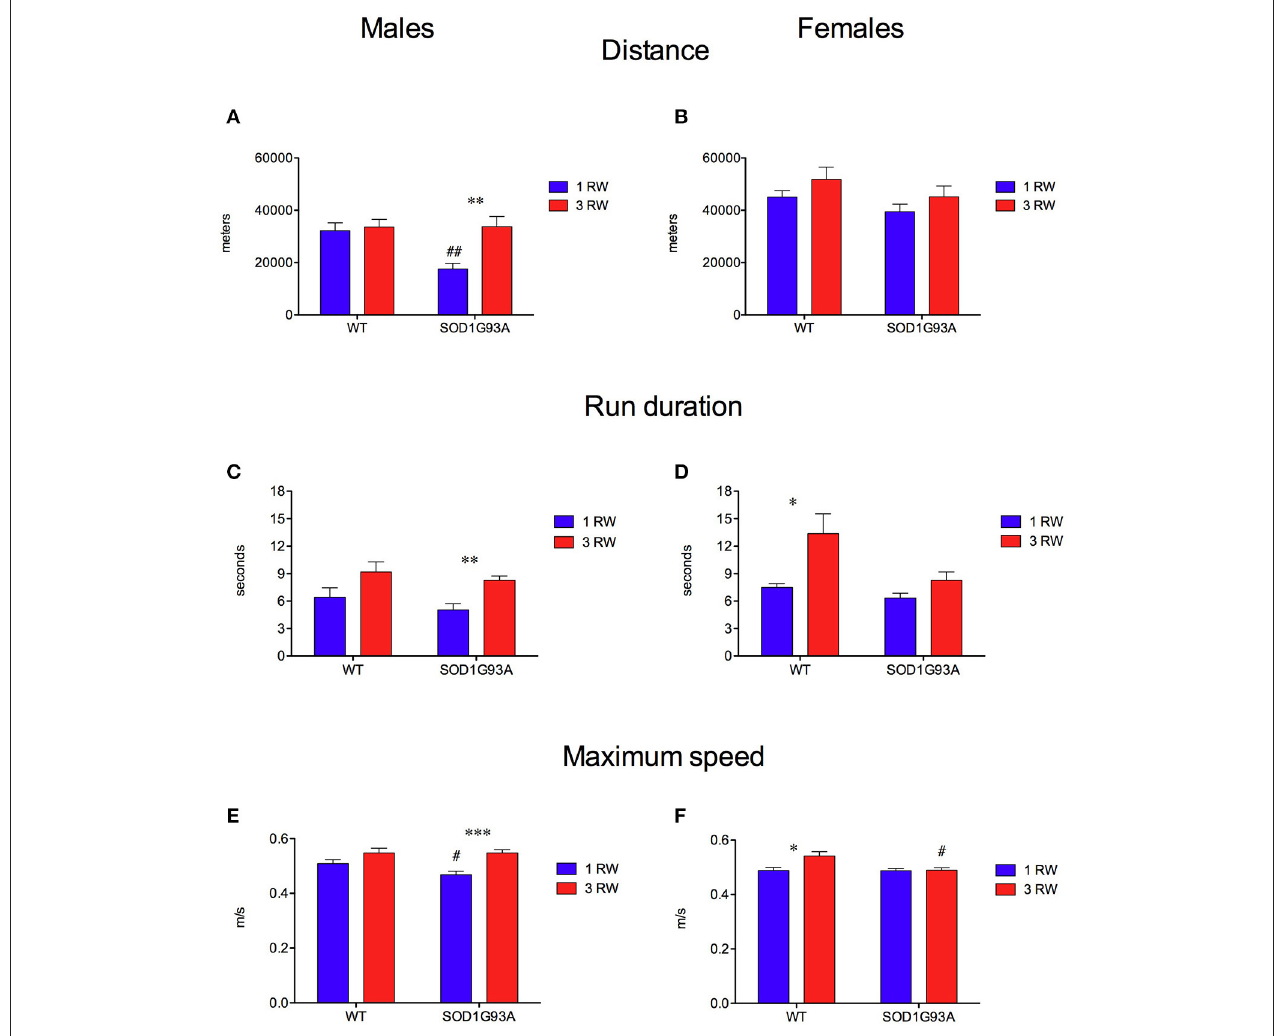
FIGURE 5 | Effect of exercise experience on running parameters during week 2 at age 24–26 weeks. (A,B) Total distance traveled (meters) on running wheels in male and female mice (mean ± s.e.m. of session’s second week). (A) Males, ANOVA: Genotype factor, F (1,33) = 5.674, P = 0.023; Exercise factor, F (1,33) = 8.502, P = 0.0063; Genotype × Exercise, F (1,33) = 5.906, P = 0.02. t -test: ** P = 0.0014 1 RW vs. 3 RW in SOD1G93A low-copy mice; ## P = 0.001 WT vs. SOD1G93A low-copy in 1 RW group. (B) Females, ANOVA: All factors are n.s. (C,D) Mean duration (seconds) of running episodes ( > 30 rpm) on running wheels in male and female mice (mean ± s.e.m. of session’s second week). (C) Males, ANOVA: Exercise factor, F (1,33) = 12.179, P = 0.0014, other factors are n.s. t -test: ** P = 0.0014 1 RW vs. 3 RW in SOD1G93A low copy mice. (D) Females, ANOVA: Genotype factor, F (1,34) = 6.259, P = 0.017; Exercise factor, F (1,34) = 9.774, P = 0.0036. * P